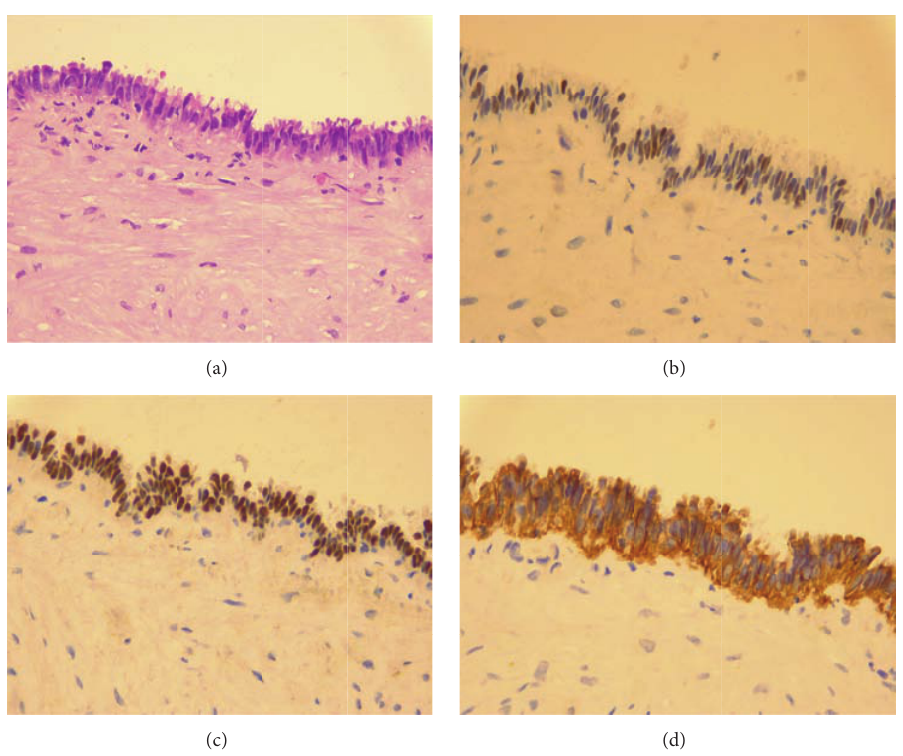
Figure 2: Microscopic view of the cystic endosalpingiosis lesions. The hematoxylin-eosin stain (a) showed a histology formed by an external serous layer, a well-organized smooth muscle and an inner layer of tubal cylindrical epithelium with small fibrous stroma papillae, no atypias, and absence of proliferative activity. Although some decidualized cells were present, no endometrial stroma was found. The immunohistochemistry analysis showed a positive expression for estrogen (b) and progesterone receptors, PAX8 (Box-8) (c) and CK7 (d), and a negative expression for CD10, calretinin, and CK20. The proliferative index with Ki67 was below